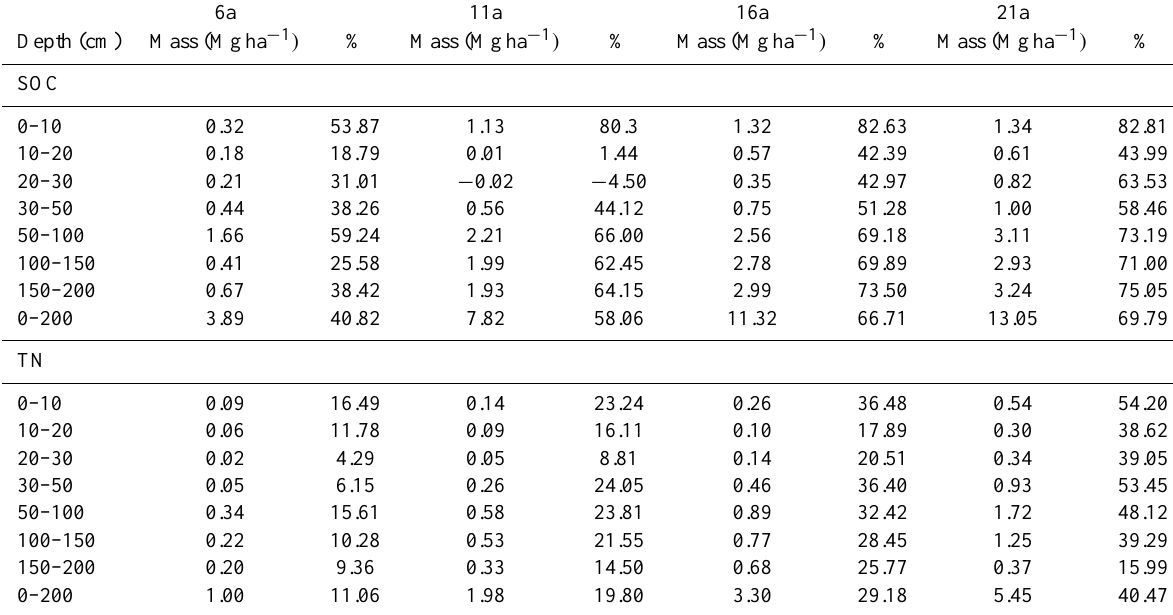
Table 3. Gains and losses of soil organic carbon (SOC) and total nitrogen (TN) at different stands relative to the 0-year stand.